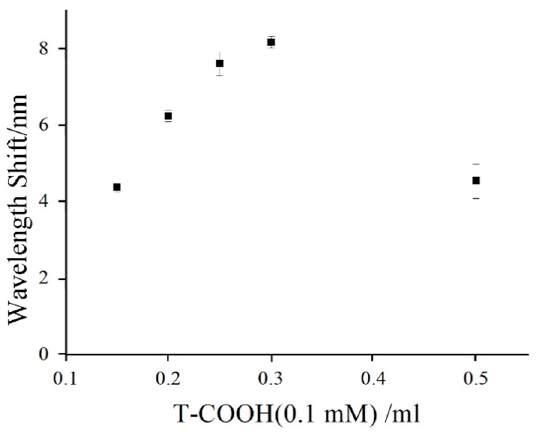
Figure 8. The optimization volumes of T-COOH (0.1 mM) for its modification on Au NPs.